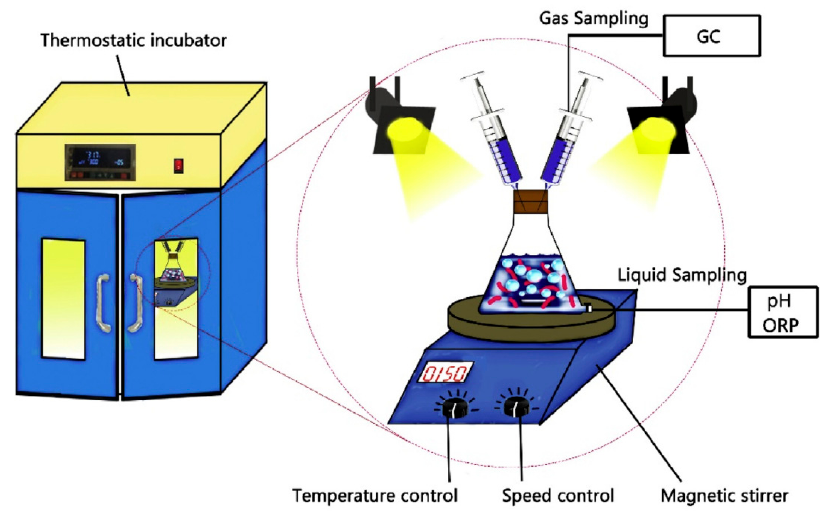
Figure 7. Diagram of photofermentation hydrogen production [122].